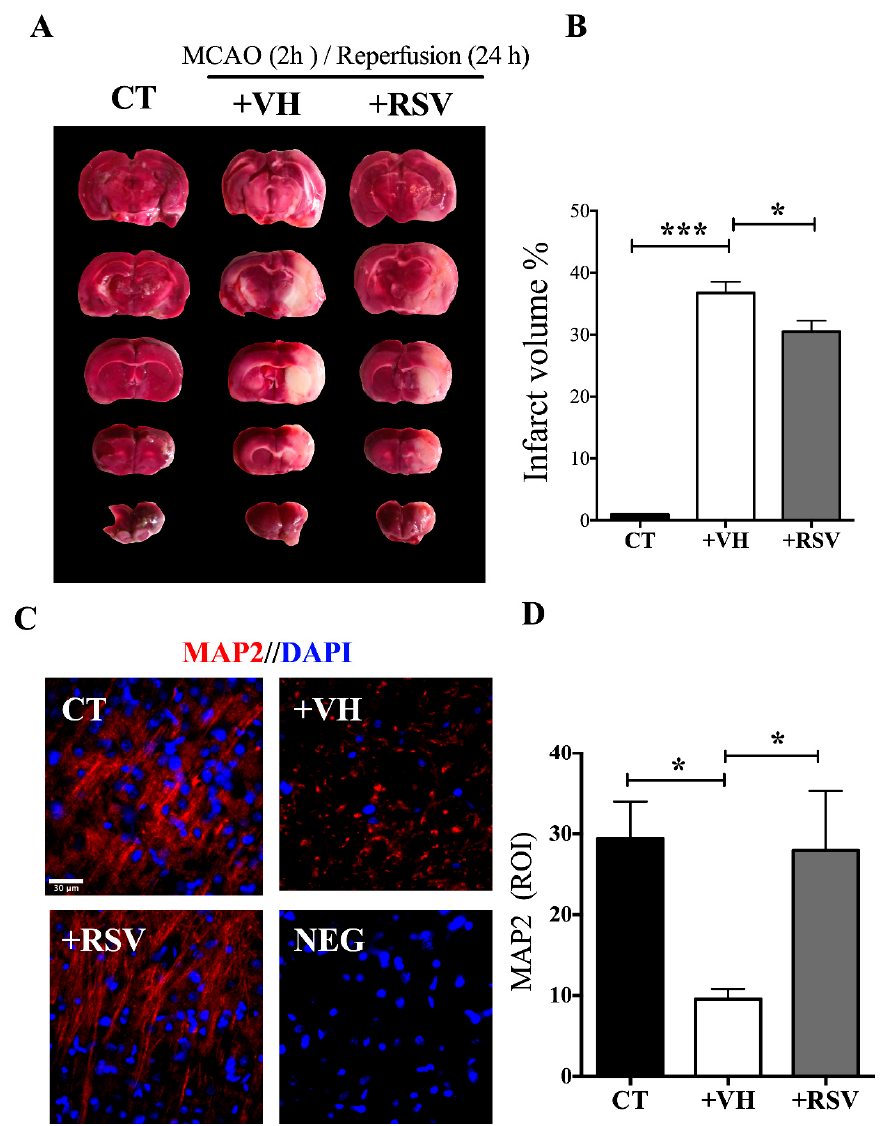
Figure 1. Resveratrol protects the brain from damage induced by ischemia. Rats were subjected to middle cerebral artery occlusion (MCAO) during 2 h followed by restoration of blood flow (reperfusion) for 24 h. Control animals (CT) were subjected to simulated MCAO. At the onset of reperfusion, rats received either vehicle, ethanol 50% (+VH) or resveratrol at 1.9 mg/kg, body weight (+RSV). Immunofluorescence was used to detect microtubule-associated protein 2 (MAP2) protein expression in neurons. 4’, 6-diamidino-2-phenylindole (DAPI) was used to detect nuclei. ( A ) Infarct area detected by 2,3,5-triphenyl tetrazolium (TTC) staining. ( B ) Quantification of the infarcted area. ( C ) Images show in red the signal associated to MAP2 and blue the nuclei. NEG, Negative control without primary antibody. ( D ) Quantification of MAP2 expression. Fluorescence was reported in % of the signal associated to MAP2 in the region of interest (ROI). Values were expressed as mean ± standard deviation. ANOVA, Tukey, * p < 0.05, *** p <